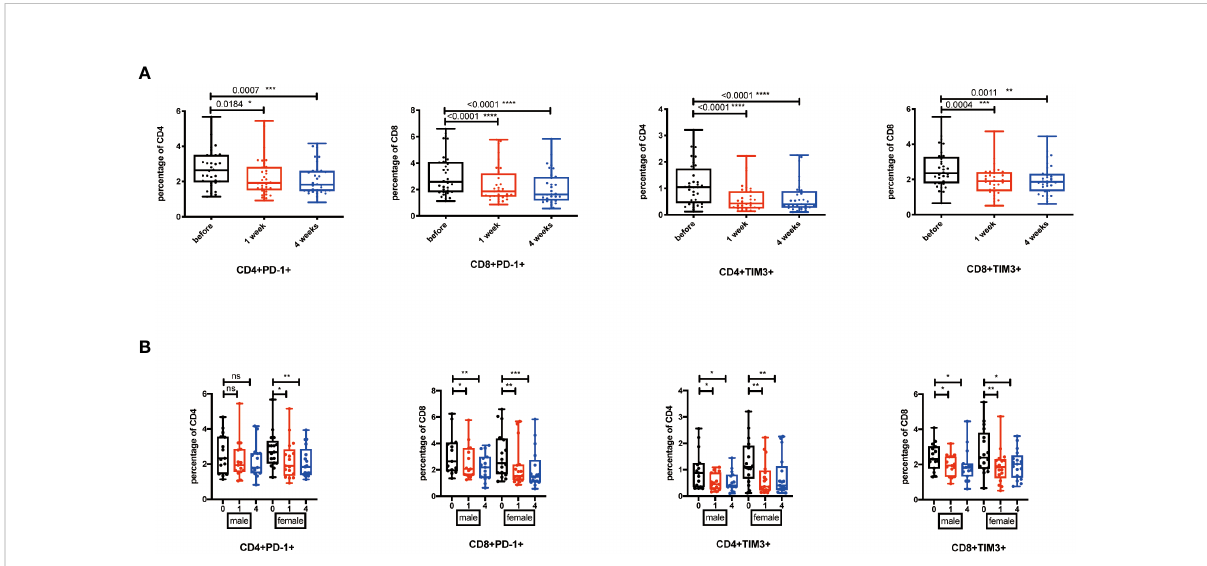
FIGURE 3 Exhausted T cells decreased after NK cell infusion. (A) Percentages of PD-1 + and TIM-3 + T cells were analyzed by fl ow cytometry on the 1 week and 4 weeks after NK cell infusion. (B) Percentages of PD-1 + and TIM-3 + T cells were analyzed in both sex by fl ow cytometry on the 1 week and 4 weeks after NK cell infusion. Each marker has detected 32 volunteers; 15 volunteers are involved in the male group, and 17 volunteers are involved in the female group. * p < 0.05; ** p < 0.01; *** p < 0.001; **** p < 0.0001. ns, no